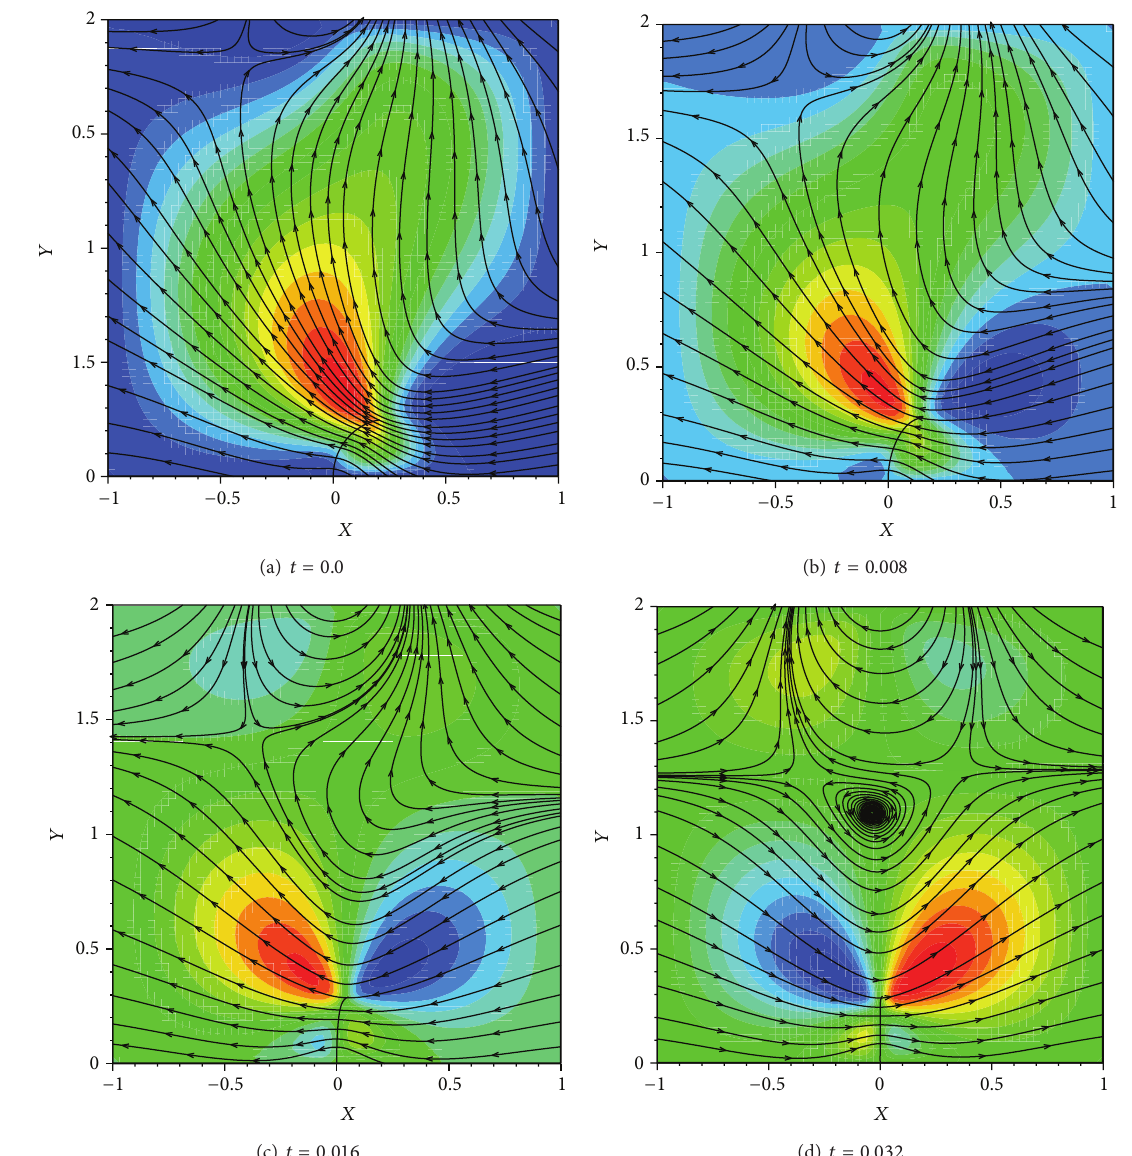
Figure 8: Contours of 𝑥 -component velocity along with streamlines at different times of 0.0, 0.008, 0.016, and 0.032 corresponding to the frames, (a), (b), (c), and (d),